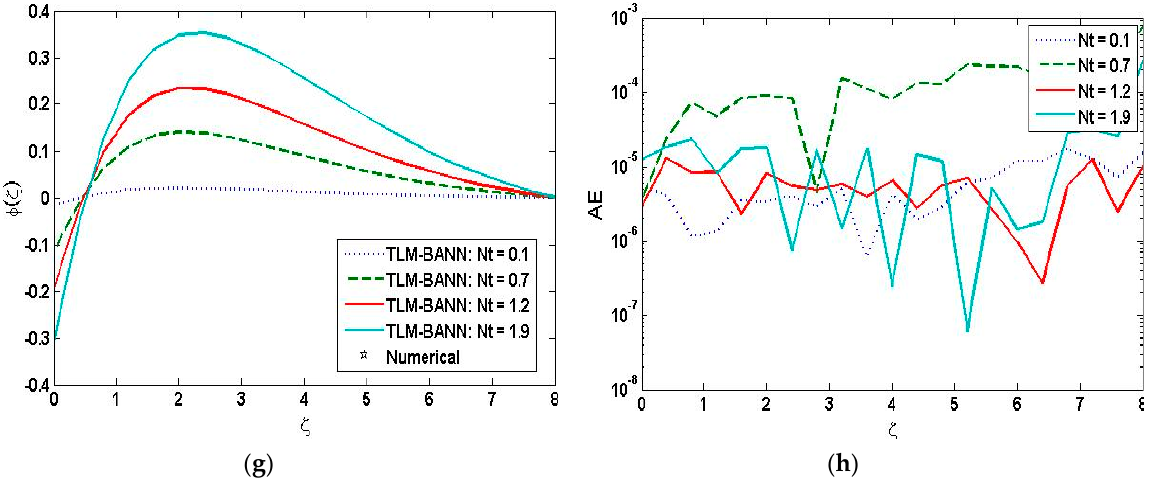
β for ϕ ; ( b ) AE anal- β α for ϕ ; ( e ) Variation of